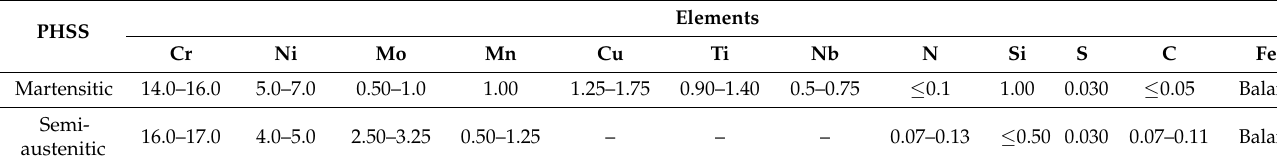
Table 1. Chemical composition of the martensitic and semi-austenitic precipitation hardening stainless steel